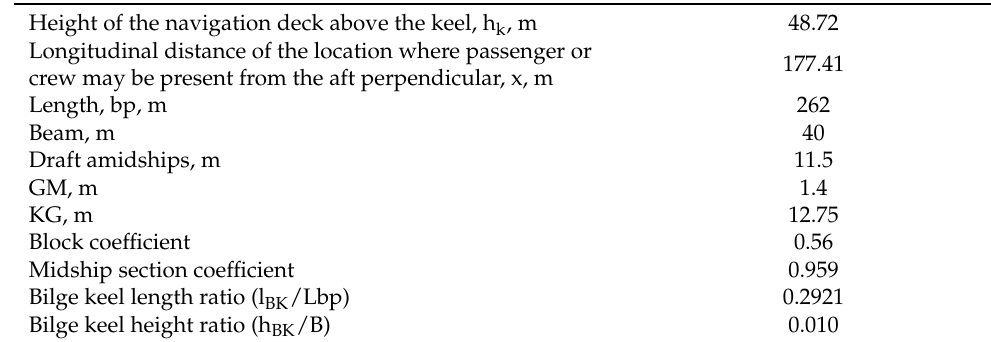
Table 3. C11 class post-Panamax container ship characteristics. Height of the navigation deck above the keel, h k ,